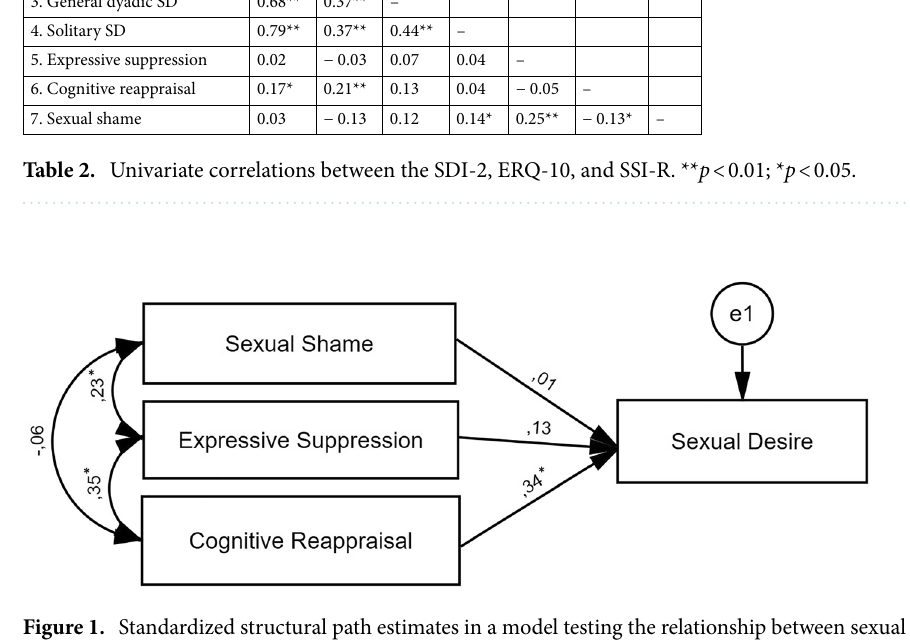
Figure 1. Standardized structural path estimates in a model testing the relationship between sexual shame, expressive suppression, and cognitive reappraisal (standardized regression coefficients and correlation between variables). *p < 0.001.